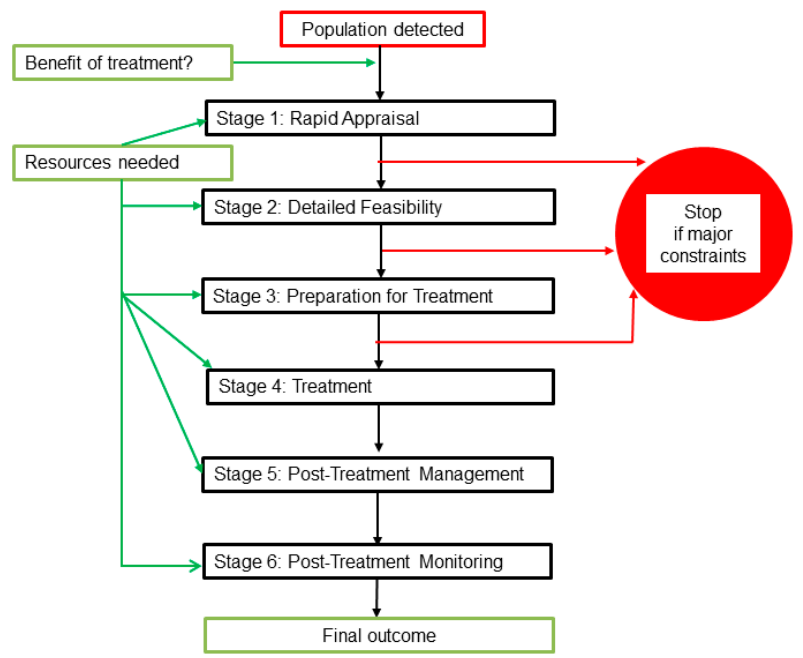
Figure 3. A summary of the work stages for biocide treatments against signal crayfish.